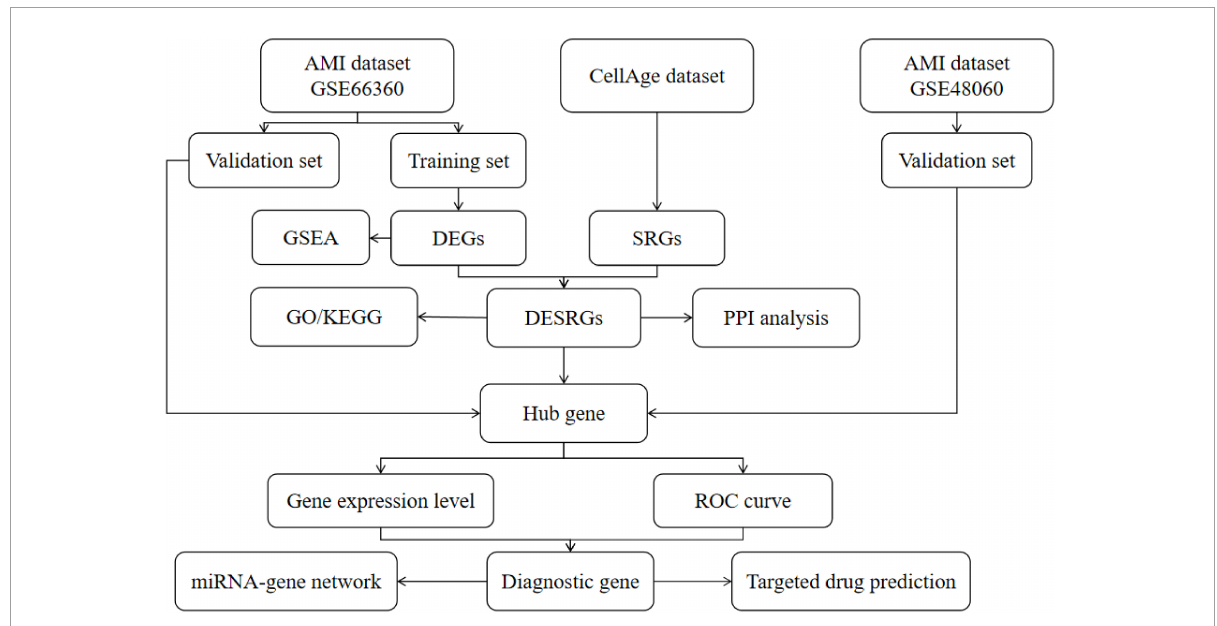
FIGURE1 The flow chart of this study. DEGs, differentially expressed genes; SRGs, senescence-related genes; GSEA, gene set enrichment analysis; DESRGs, differentially expressed senescence-related genes; GO, Gene Ontology; KEGG, Kyoto Encyclopedia of Genes and Genomes; ROC, receiver operating